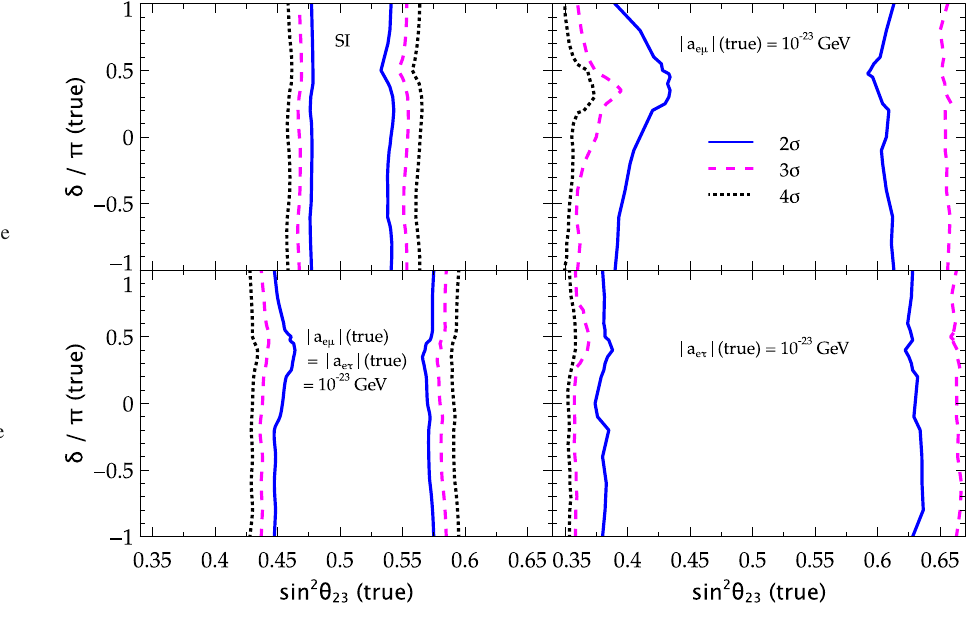
(right) panel. In addition to this, in the left (right) panel, the true and test values of the new CP phase ϕ e μ ( ϕ e τ ) have been marginalized away in the entire range of [− π, π ] . We show the results at three different confidence levels (1 d.o.f.): 2 σ (solid blue curves), 3 σ (dashed magenta curves), and 4